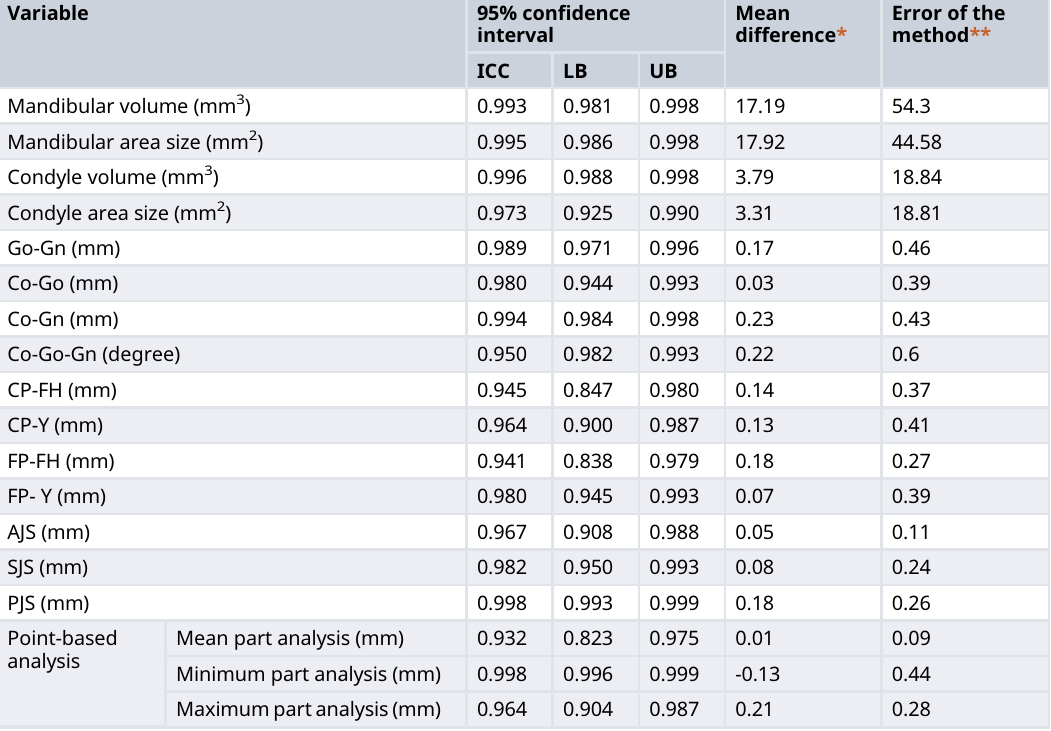
Table 3. Reliability of the performed measurements and error of the method. Variable